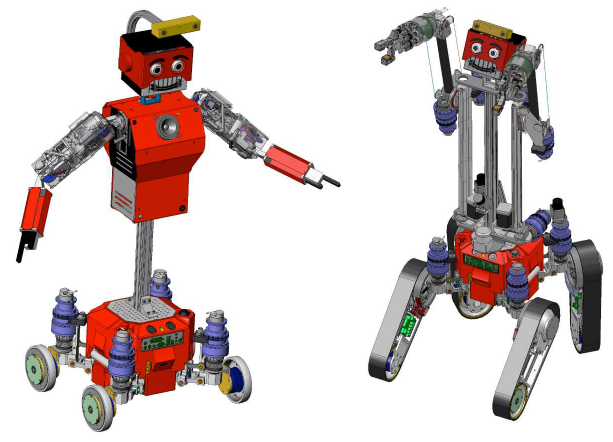
Figure 1. Johnny-0 robot platform